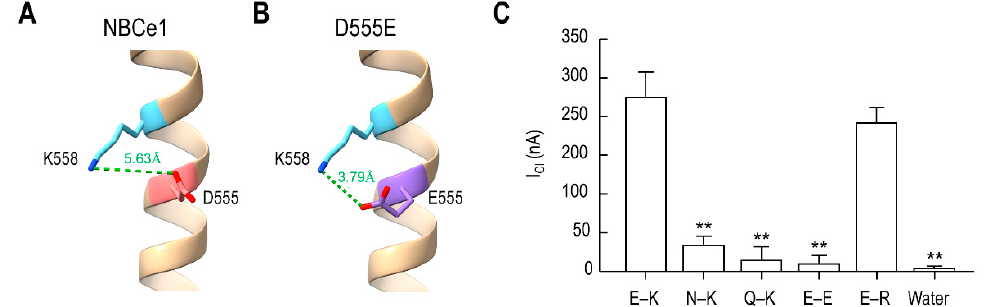
Figure 7. A charge interaction between Glu 555 and Lys 558 induces I Cl . ( A , B ) Bond length between the carboxyl group in the side chain of Asp 555 ( A ) or Glu 555 ( B ) and the amino group of Lys 558 . The length in angstrom was determined using the molecular visualization program ChimeraX with the rotamer probability of higher than 0.05. A hydrogen bond was identified when the bond length was < 4 Å. ( C ) Comparison of I Cl produced by mutations of Glu 555 and Lys 558 . E–K is the Glu 555 –Lys 558 pair ( n = 7). N–K and Q–K are the replacement of Glu 555 with an asparagine and a glutamine, respectively ( n = 5/group). E–E and E–R are the replacement of Lys 558 with an aspartic acid and an arginine, respectively ( n = 4–5/group). Controls were water-injected oocytes ( n = 4). ** p < 0.01 compared to